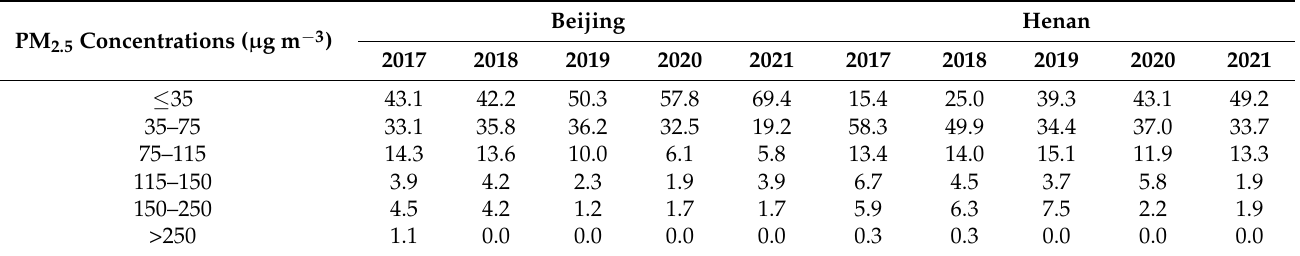
Table 1. Proportion (%) of different concentration levels during 2017–2021 in Beijing and